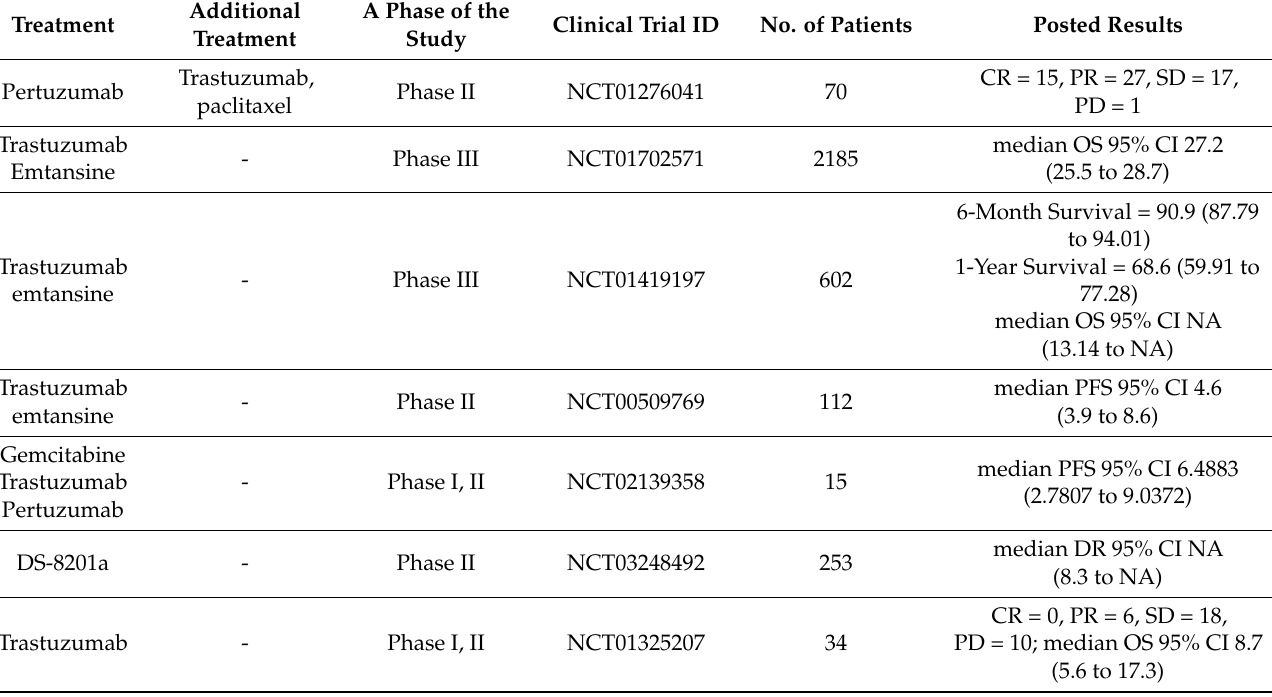
Table 2. The clinical trial results for HER2-targeted therapy in